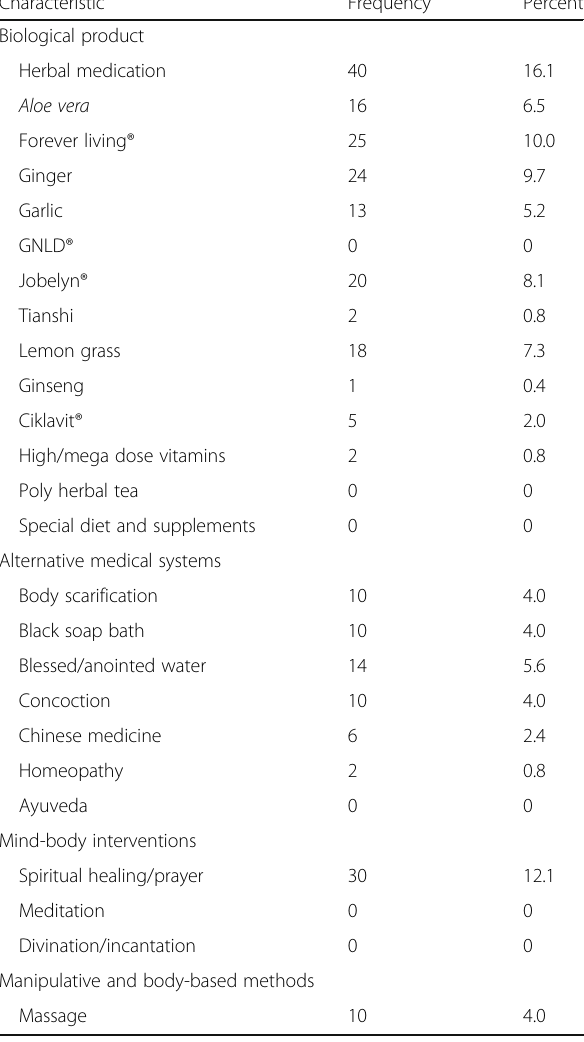
Table 2 Pattern of CAM components used by the